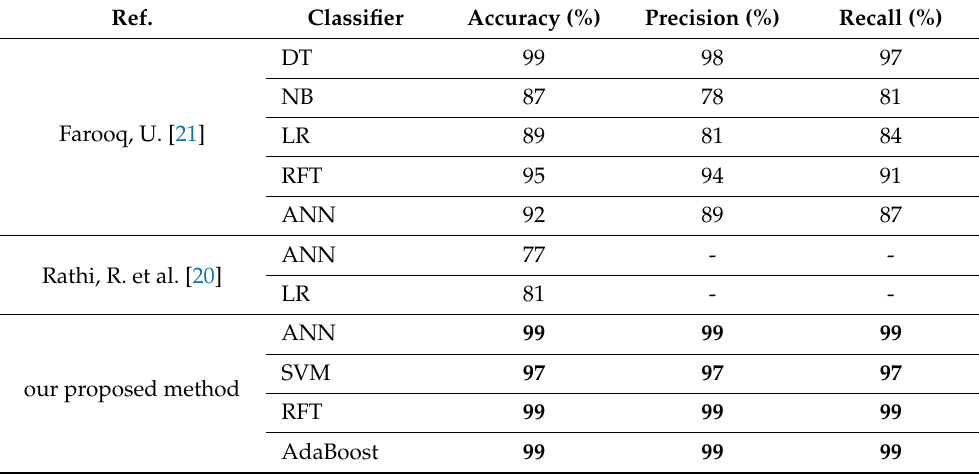
Table 6. Performance comparison of the proposed password strength estimation with state-of-the-art.